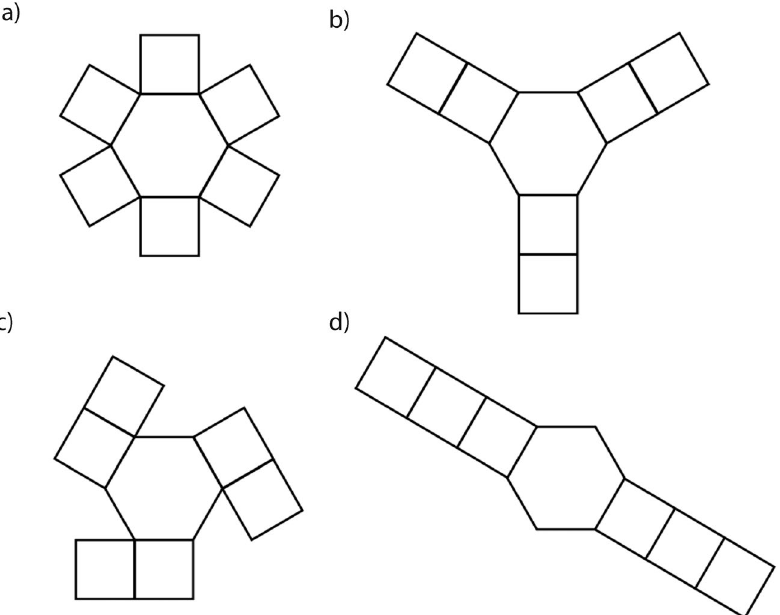
Figure 3. Planar configurations of one hexagon and six squares, from which one can intuit that it would be impossible for any of them, or any other one for that matter to be closed as a 3D polyhedron without creating at least a second hexagonal